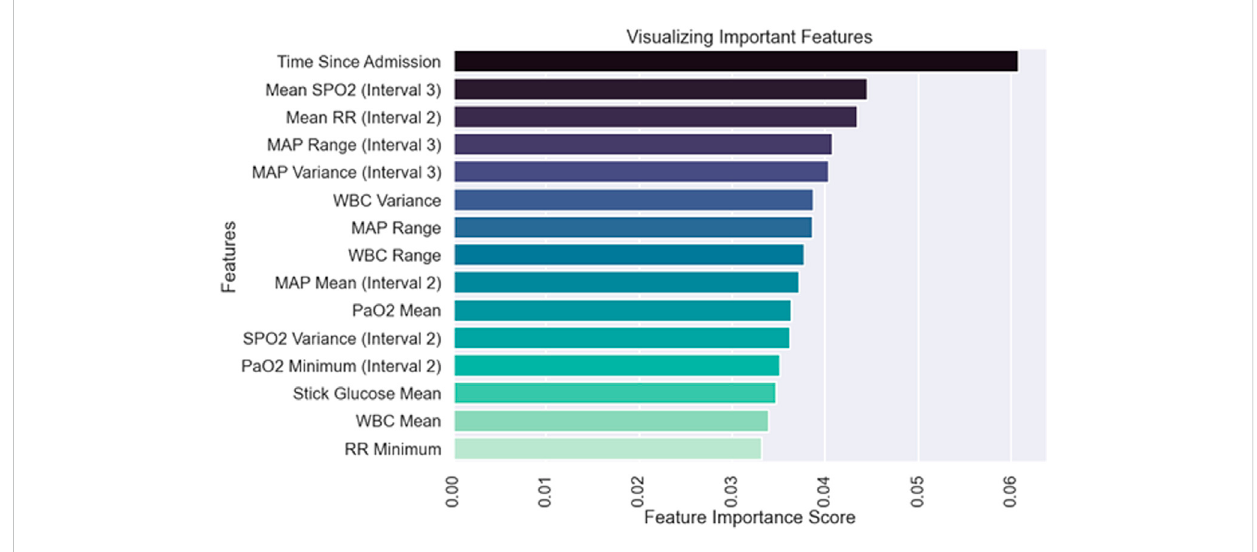
FIGURE 7 Top 15 signi fi cant Features from Cohort 2 manually derived features